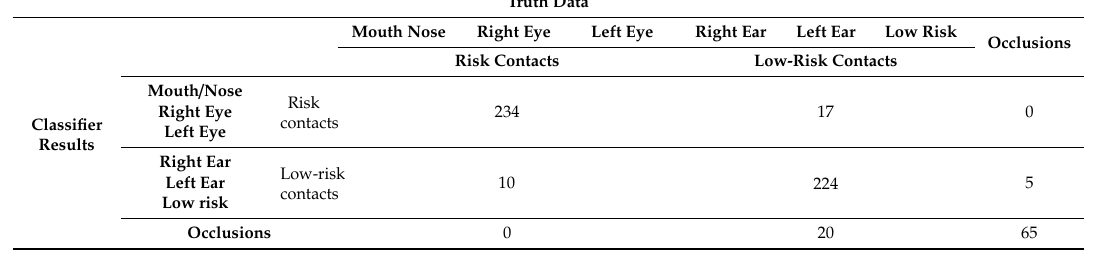
Table 2. The confusion matrix for the three-class classification.